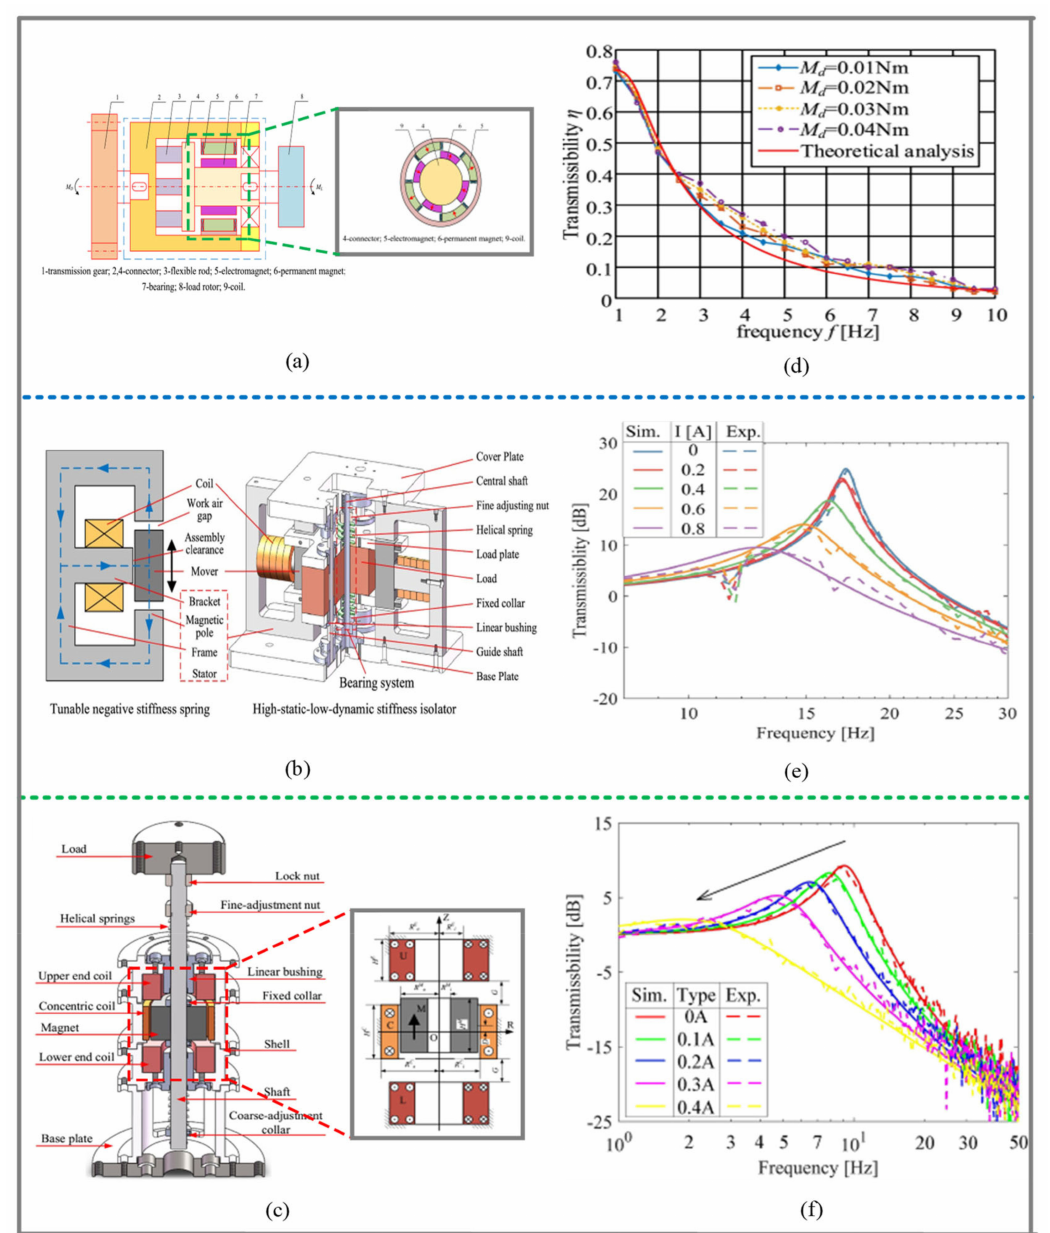
Figure 16. Structure and vibration isolation performance of three typical magnetic QZS isolators: ( a ) The permanent magnet structure for suppressing low-frequency torsional vibrations proposed by Xu et al. [59]; figures adapted with permission from Ref. [59]. Copyright 2020, copyright Xu, J.; ( b ) The electromagnetic structure using Maxwell normal stress proposed by Yuan et al. [75]; figures adapted with permission from Ref. [75]. Copyright 2021, copyright Yuan, S.; ( c ) The hybrid magnet structure composed of the ring coil and permanent magnet proposed by Yuan et al. [77]; figures adapted with permission from Ref. [77]. Copyright 2020, copyright Yuan, S.; ( d – f ) show the corresponding transmissivity